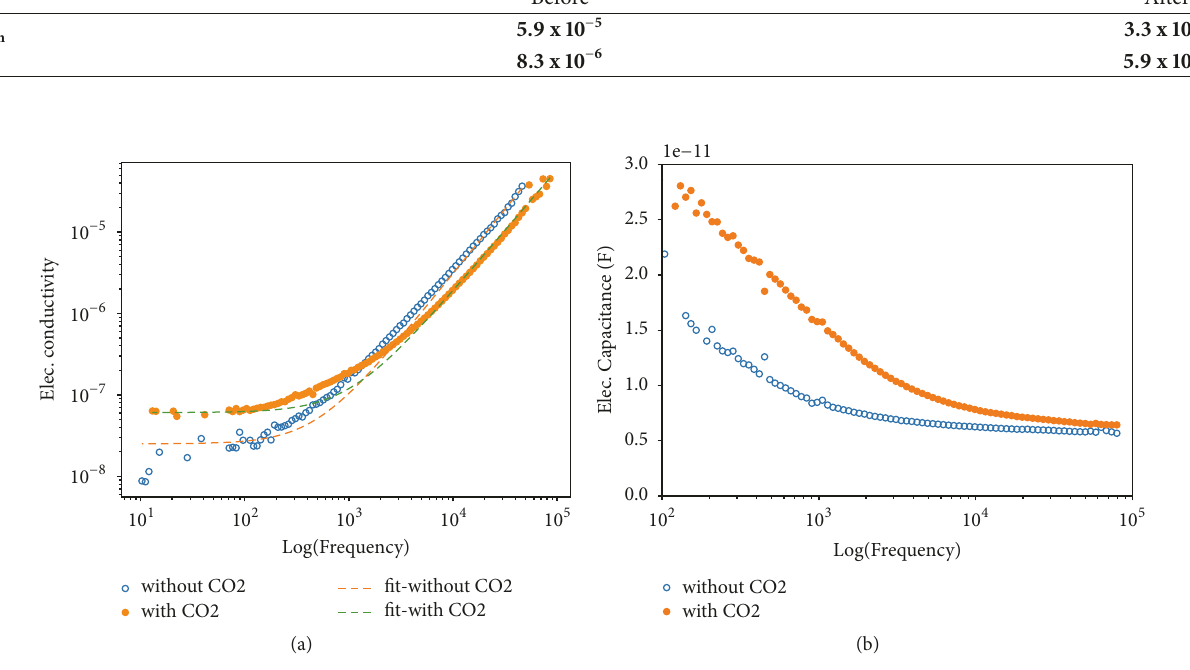
Figure 7: Effect of CO 2 adsorption on the electrical conductivity (a) and electric capacitance (b) of Z5A-1 at 433 K. The dashed lines are fittings with Jonscher’s power law.